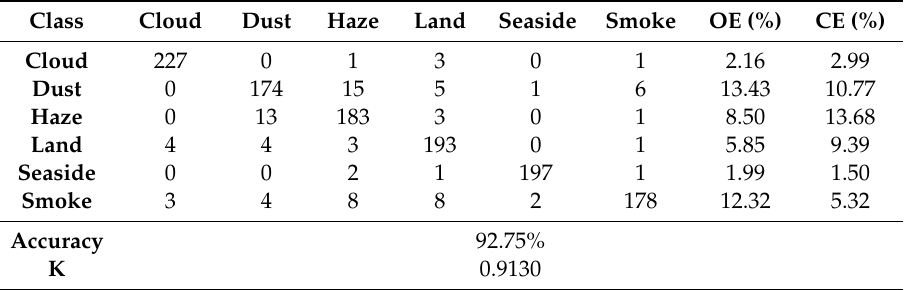
Table 7. Confusion matrix on testing set of the SmokeNet model trained with 64% training